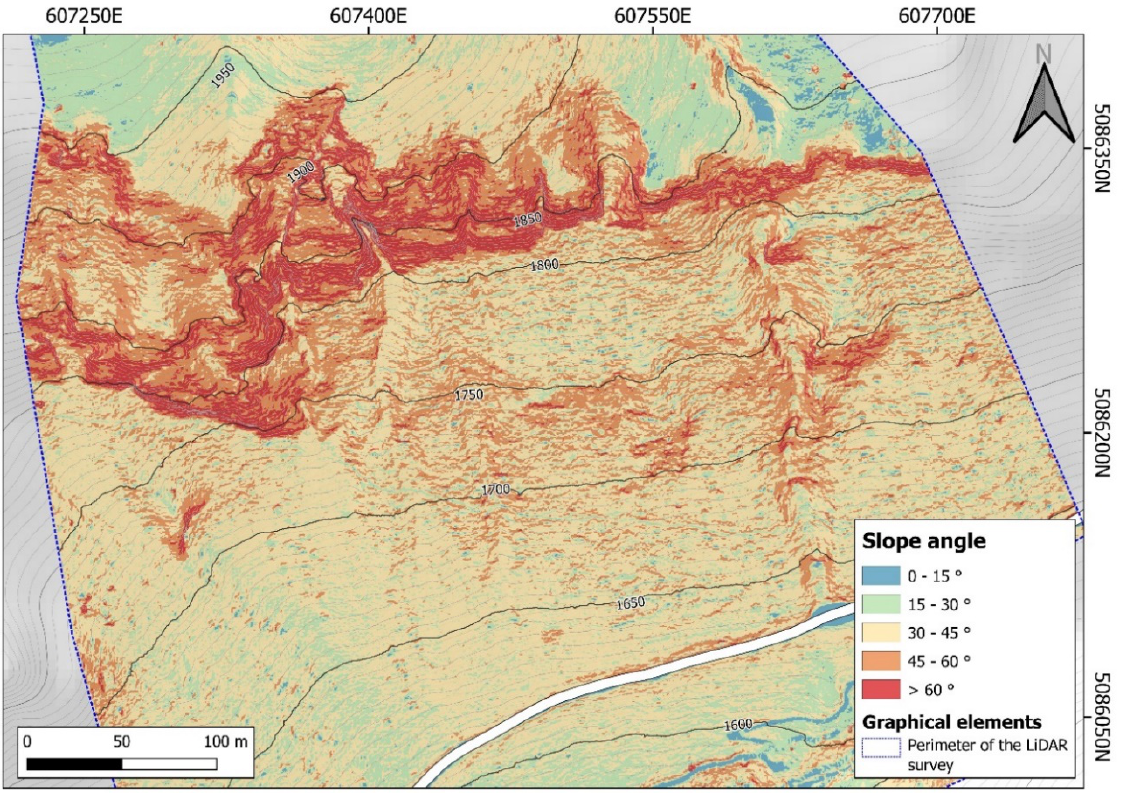
Figure 5. Slope angle from the LiDAR survey DTM for the entire study area: the area appears quite steep, with an average of 62 ° and a maximum of 88 °; the rock faces at the top are well defined by the red and orange portions of the image.